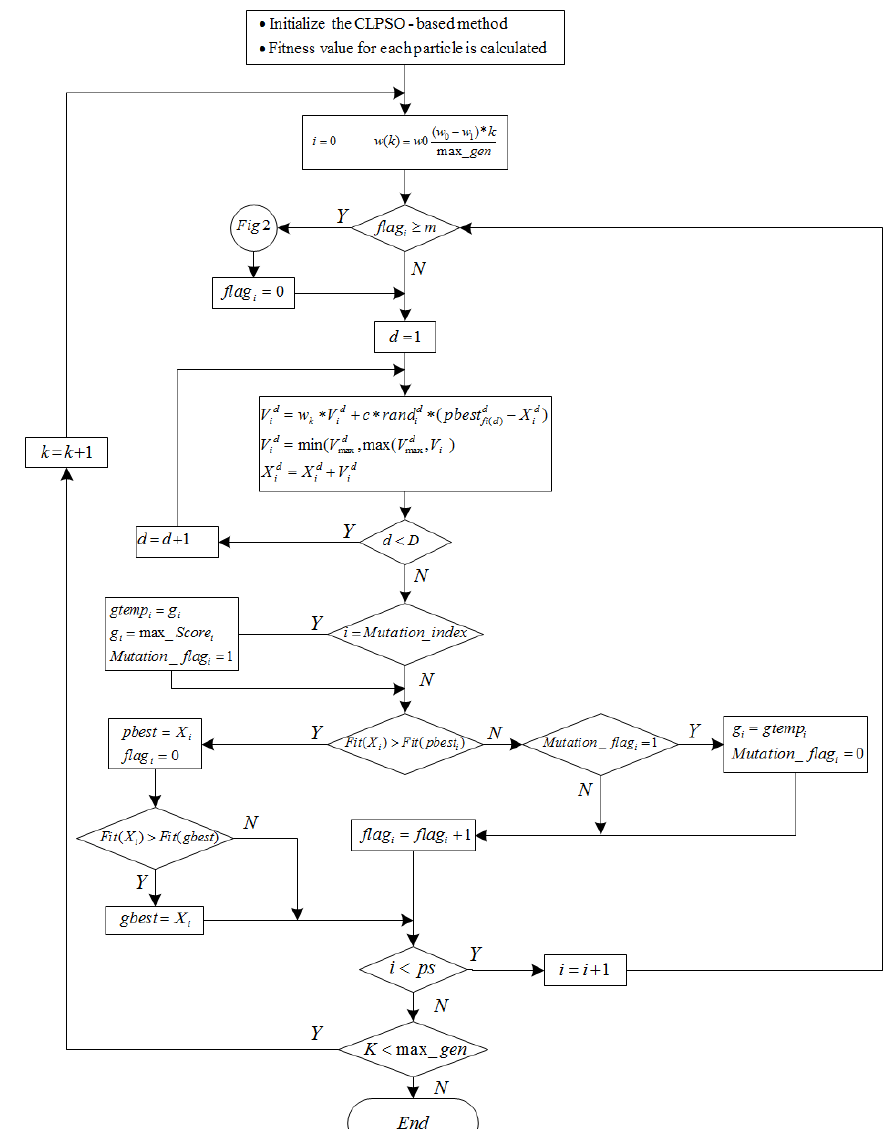
Figure 3. Flowchart of the modified